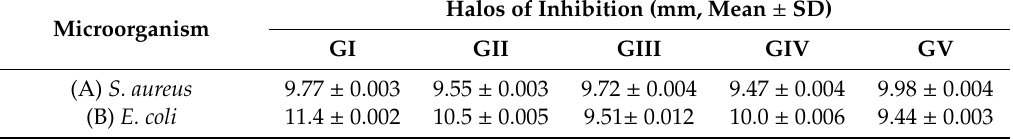
Table 1. Results of disc di ff usion test against Staphylococcus aureus and Escherichia coli in contact with silver nanoparticles (AgNPs) (mean and standard deviation). For bracket names, please refer to Section